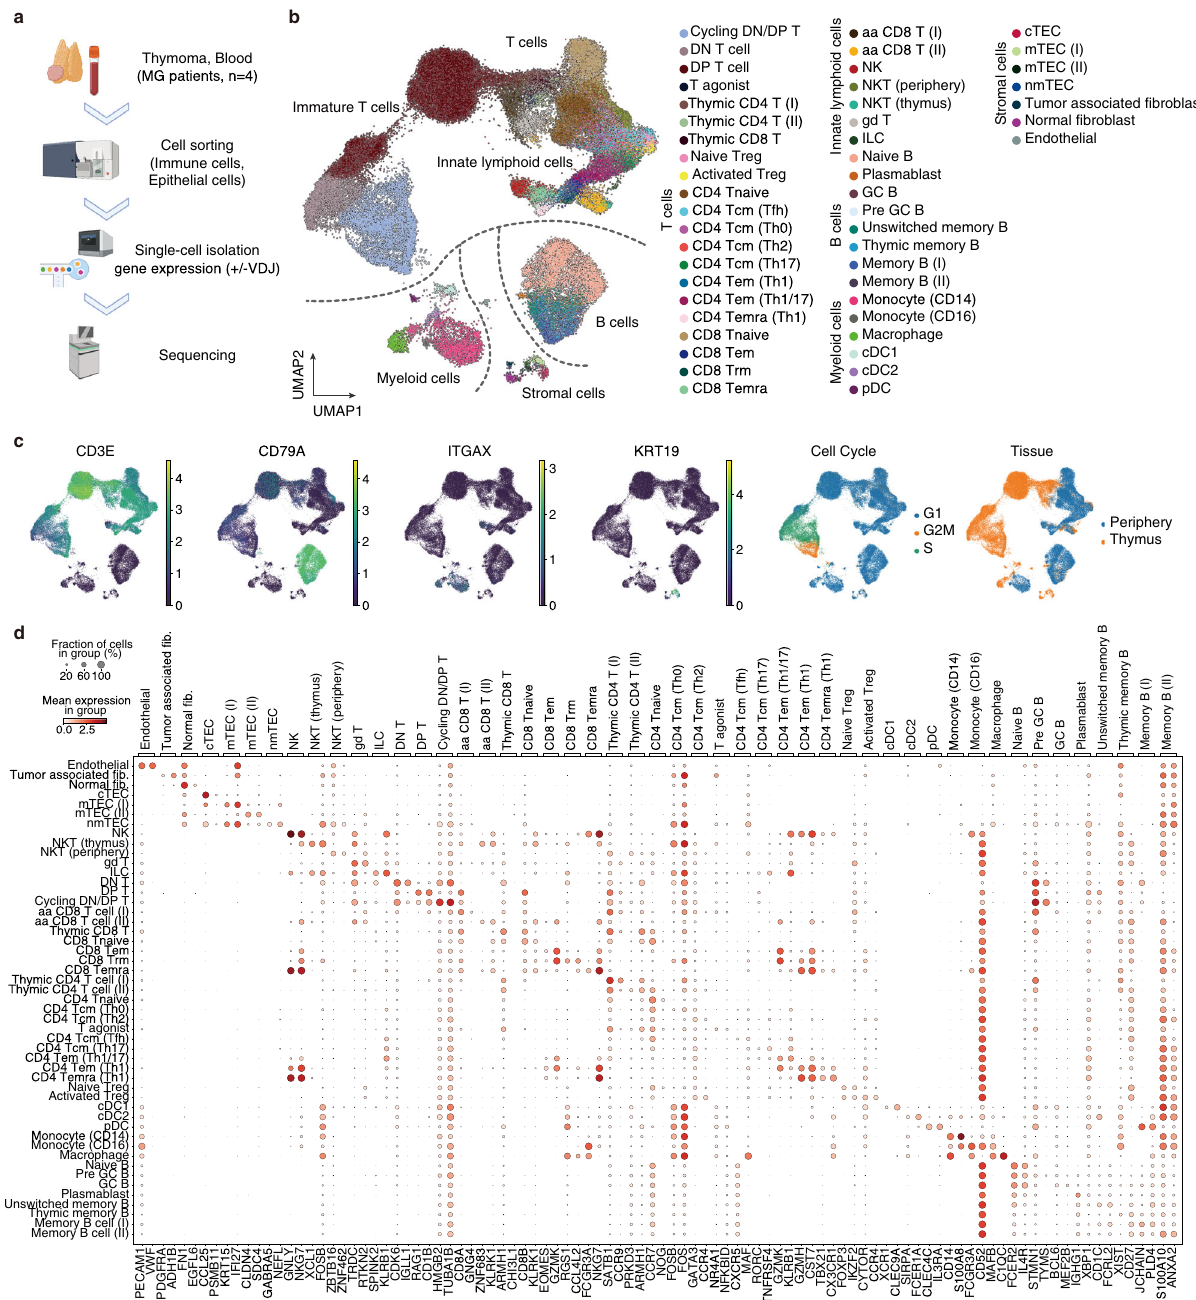
Fig. 2 Overview of scRNAseq of thymoma and blood from anti-AChR receptor antibody positive patients. a The experimental design of scRNAseq. Immune cells and non-immune cells from MG-type thymoma and immune cells from the blood of corresponding patients were collected for scRNAseq. b UMAP plot for 65,935 cells displaying the 49 clusters from thymoma and blood of MG patients. c UMAP plot of marker genes, inferred cell cycle, and tissue origins. d Dot plot depicting signature genes ’ mean expression levels and percentage of cells expressing them across clusters. The detailed dot plot is shown in Supplementary Fig.